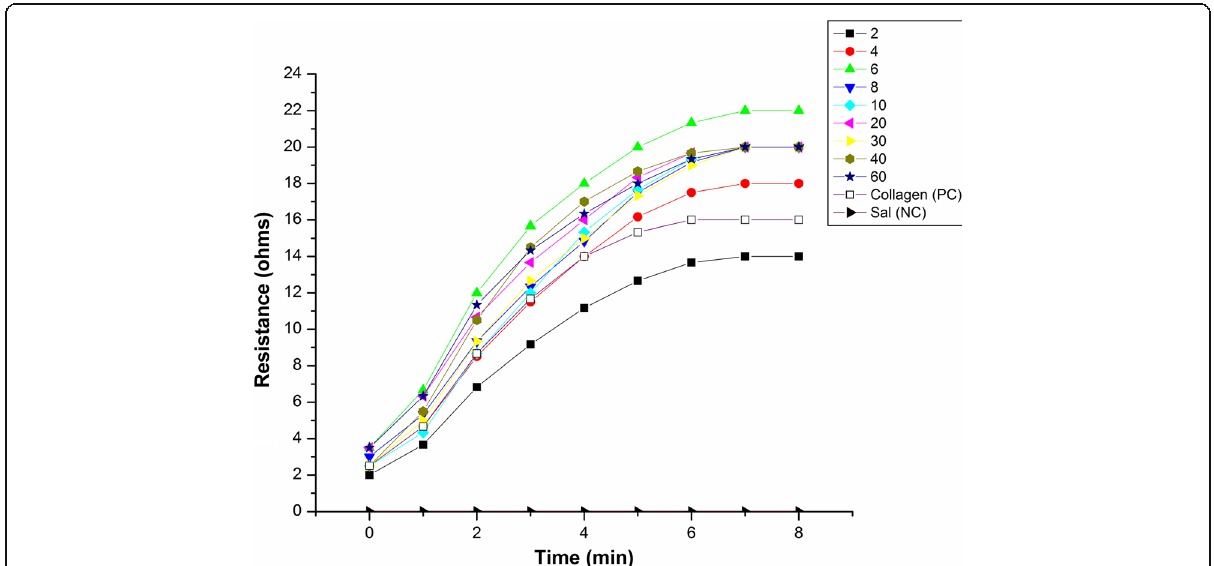
Fig. 9 Effect of SCF on collagen-induced platelet aggregation. Blood was treated with different dosages of SCF and platelet aggregation was induced by collagen. PC = Blood incubated with saline and collagen; NC = blood incubated with saline only (no agonist added). SCF